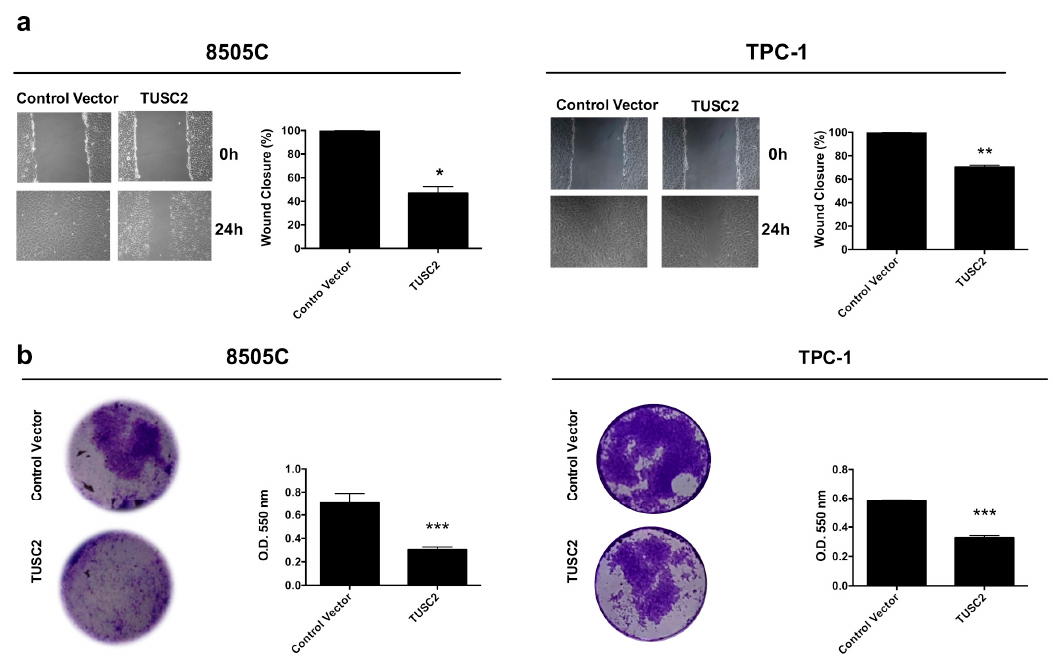
Figure 3. TUSC2 forced expression reduced thyroid cancer cell motility. ( a ) A wound was introduced on a confluent monolayer of 8505C (left) and TPC-1 (right) cells stably transfected with TUSC2 plasmid or Control Vector, and cell migration into the wound was monitored for 24 h. Images were taken at 10 × magnification. Wound closure was measured by calculating pixel densities in the wound area and expressed as percentage ± standard errors. ( b ) Stably transfected 8505C (left) and TPC-1 (right) cells were plated on a Matrigel matrix and allowed to invade the Transwell insert for 24 h. Invaded cells were stained, photographed and quantified by measuring the absorbance at O.D. 550nm. Bars indicate the mean of duplicate experiments ± standard errors. Asterisks indicate * p < 0.05, ** p < 0.01 and *** p < 0.001.